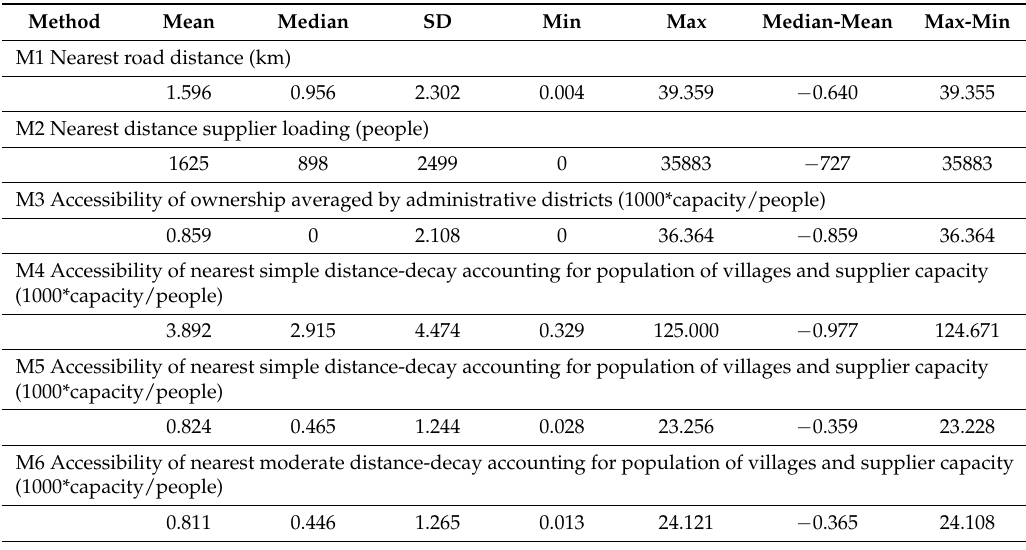
Table 3. Summary statistics of community care resources accessibility